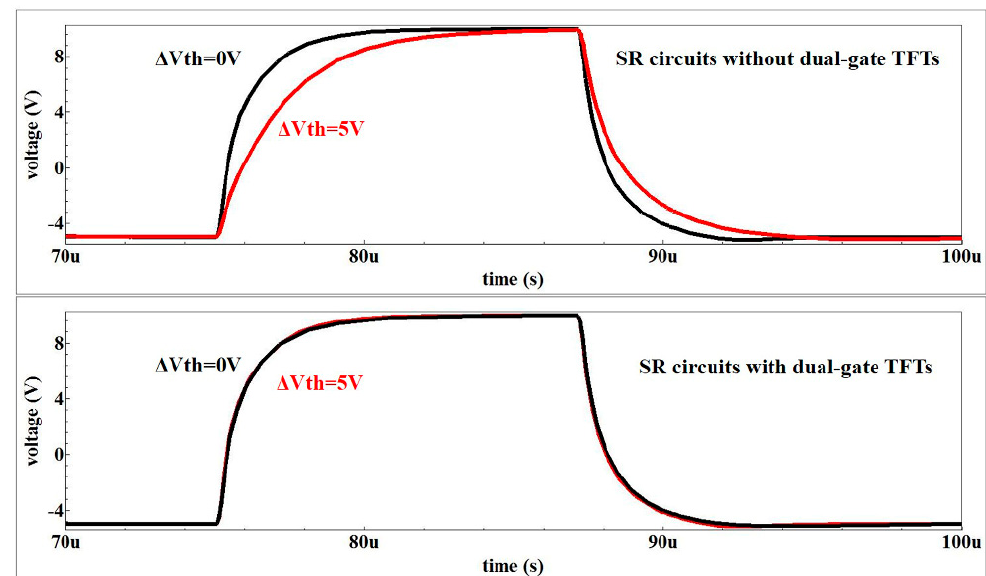
Figure 6. The effect of M0 voltage to Vth in dual-gate TFTs.